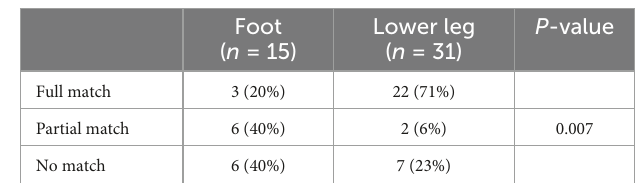
TABLE 4 Classification of in-transit metastatic patterns defined by localization of primary